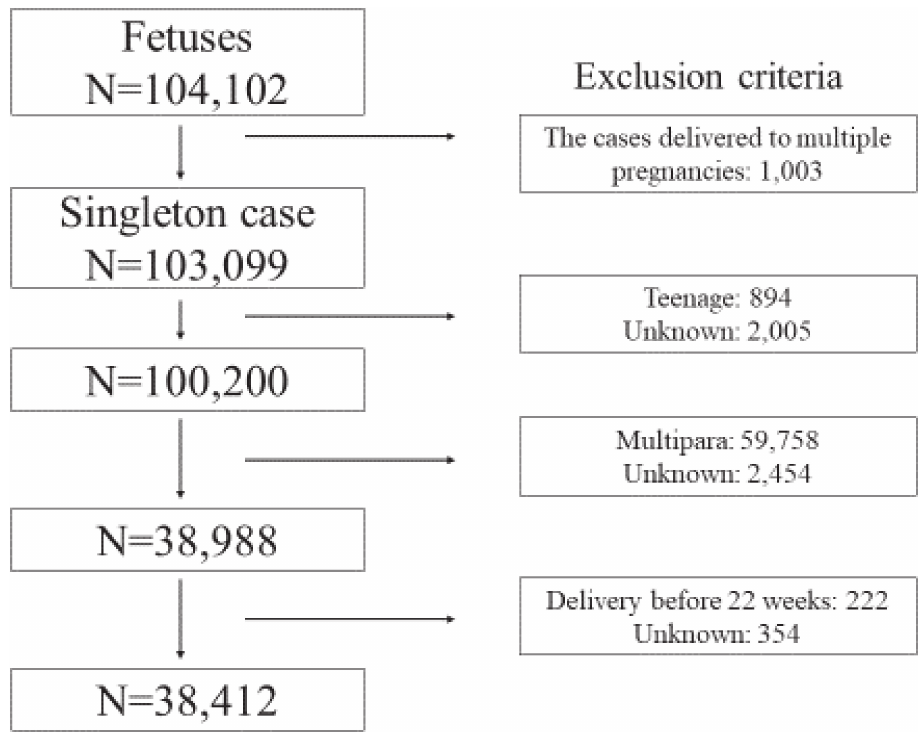
Figure 1. Study enrollment fl